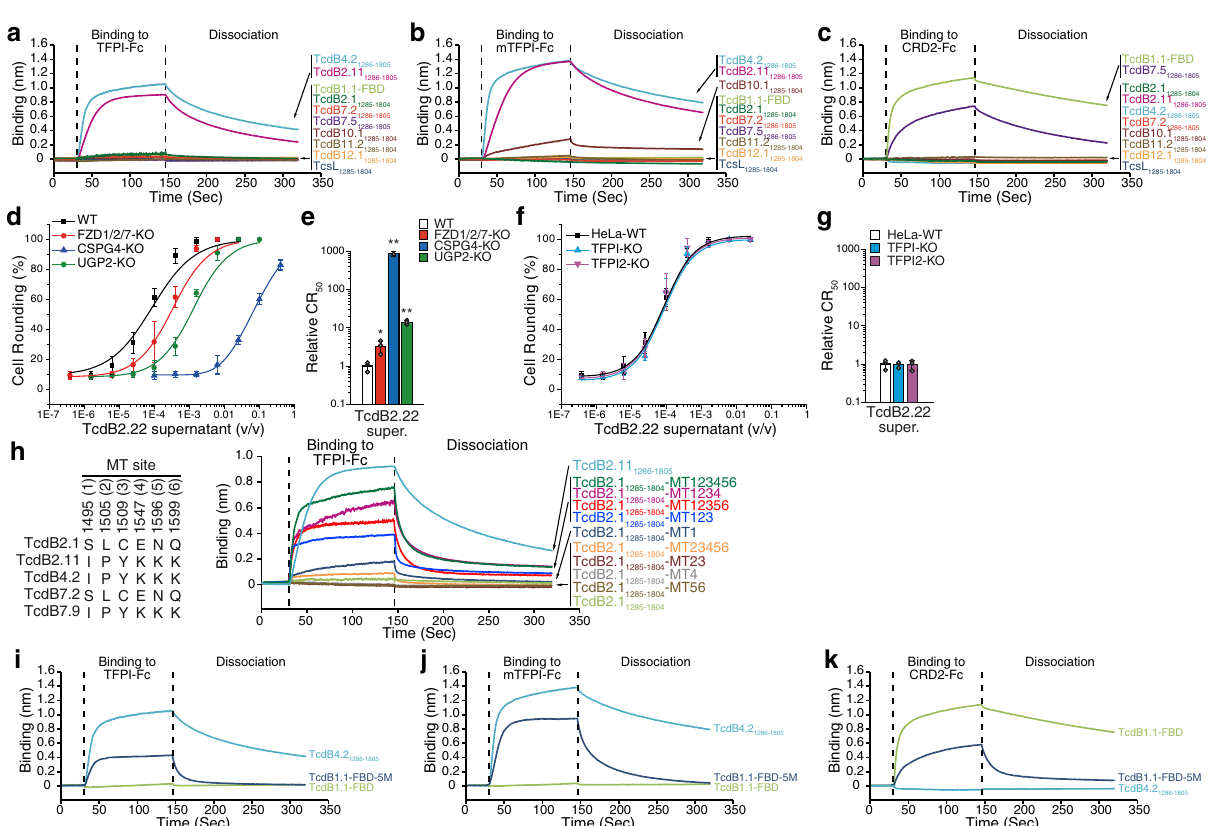
celllineswerenormalizedtotheWTandplottedasbar-chart( g ).Errorbarsindicate mean±s.d.; N =3 (biologically independent experiments). h There are six residues that are different between TFPI-binding TcdB4.2, 2.11, 7.9 versus TcdB2.1 and 7.2 (1495,1505,1509,1547,1596,and1599,markedasMTsite1 – 6).Mutagenesisstudies were performed to replace the indicated residues on TcdB2.1 1285-1804 with the corresponding residues found in TcdB4.2. The binding of the indicated mutant proteins (500nM) to immobilized TFPI-Fc was analyzed using BLI assays. TcdB2.11 1286 – 1805 and TcdB2.1 1285 – 1804 were analyzed as controls. Representative sensorgramsfromoneofthreeindependentexperimentsareshown. i – k ATcdB1.1- FBD-5M mutant proteins were generated by replacing fi ve residues in TcdB1.1 with thecorrespondingresiduesfoundinTcdB4.2(positions1495,1505,1547,1596,and 1599). The binding of this mutant protein to immobilized TFPI-Fc ( i ), mTFPI-Fc ( j ), andCRD2( k )wasanalyzedusingBLIassays.TcdB1.1-FBDandTcdB4.2 1285 – 1804 were analyzed as controls. Source data are provided as a Source Data fi